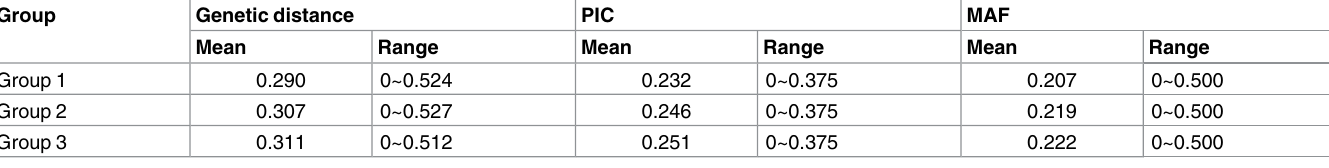
Table 4. Diversity statistics for the 197 sweet potato accessions collected in this study. Group